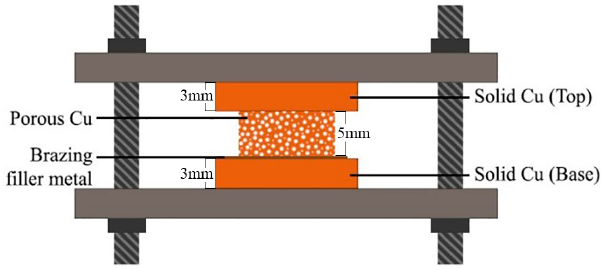
Figure 1. Schematic illustration of specimen arrangement in a clamp system.